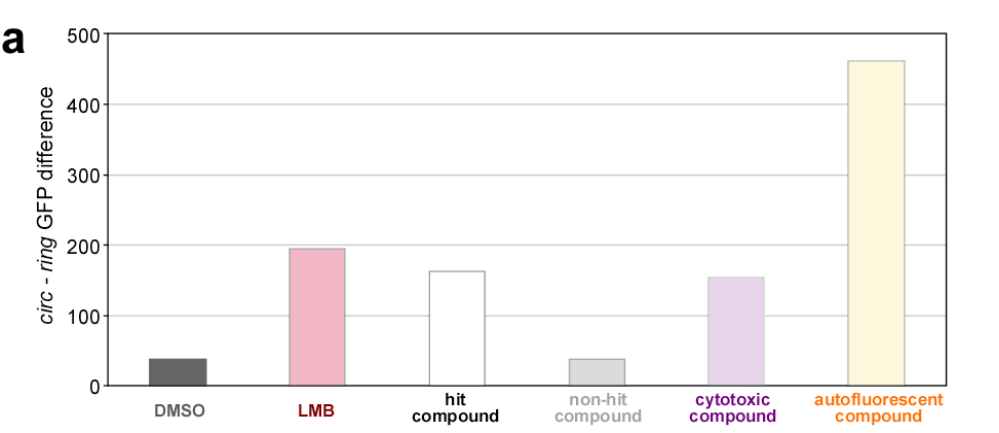
Figure 5. Intersection of the biological and chemical space. Translocation index-based analysis for cytotoxicity and fluorescence interference. (a) CIRC-RING values representative for negative and positive control substances (DMSO, LMB), export antagonists, substances showing no effect on export, cytotoxic and autofluorescent compounds obtained from the analysis of a representative 384-well plate. (b) Scatter plot of the nuclear intensity/well versus the cytoplasmic intensity/well in the “green” target channel 2 (GFP) subsequent to compound exposure to mark the intersection of the chemical and biological space. Values from a representative 384-well plate are shown. The DMSO controls (dark grey) are grouped together with the non-hit compounds (light grey), and are well separated from the LMB controls (red) and a potential hit population (black dotted circle). Potential hit compounds partially overlap with cytotoxic substances (violet), identified by visual inspection. Autofluorescent compounds (orange) usually display high fluorescence intensities and are well separated. (c) Representative images from compound wells that exhibited either a dose-dependent autofluorescence (upper panel) or a dose- dependent cytotoxicity (lower panel). Raw images and mask overlays are shown for both channels. In the Hoechst channel, objects selected for further analysis are outlined in blue, objects rejected are outlined in orange. In the “GFP channel”, the green outline represents the nuclear region mask, and the red outline the cytoplasmic ring region. Scale bar, 50 μ m. The chemical structure of the respective compounds are shown on the